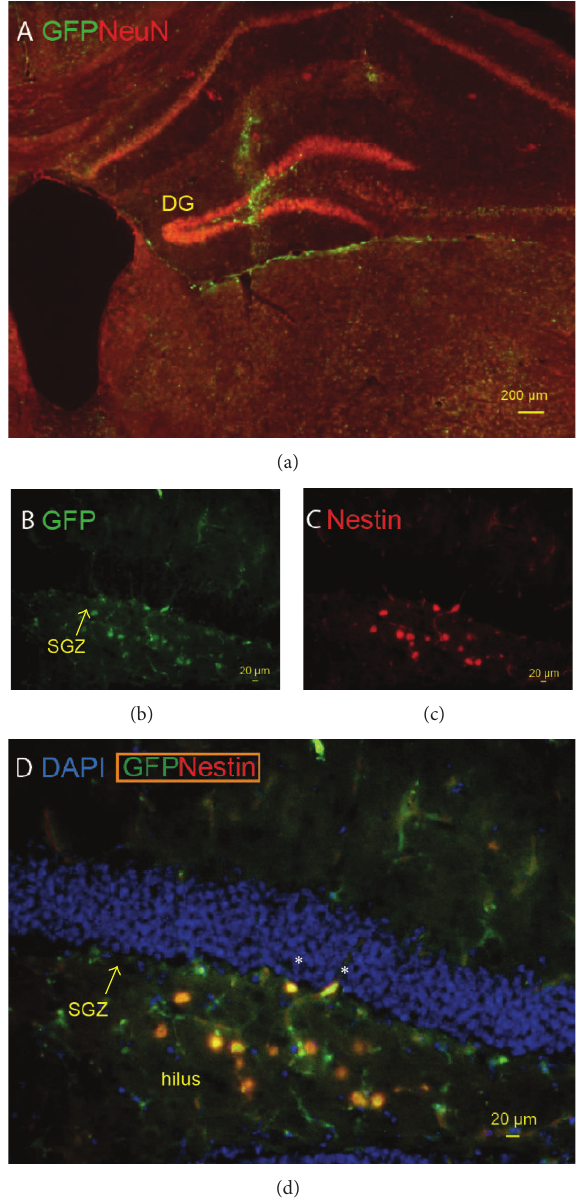
Figure 6: Chimeric mice stained for GFP (green) and Nestin (red). (a) GFP+ cells can be seen along the needle track and infiltrating in the sub-granular zone (SGZ) of the dentate gyrus (DG) and the CSF fluid space ventral to the hippocampus (scale bar = 200 𝜇 m). (b) GFP+ cells in the SGZ of the DG. (c) Nestin+ cells in SGZ of the DG. Most of the GFP+ cells are in the hilus (also known as CA4). (d) Merged image illustrating coexpression of GFP and nestin in two cells (asterisks) in the immediate SGZ (scale bar = 20 𝜇